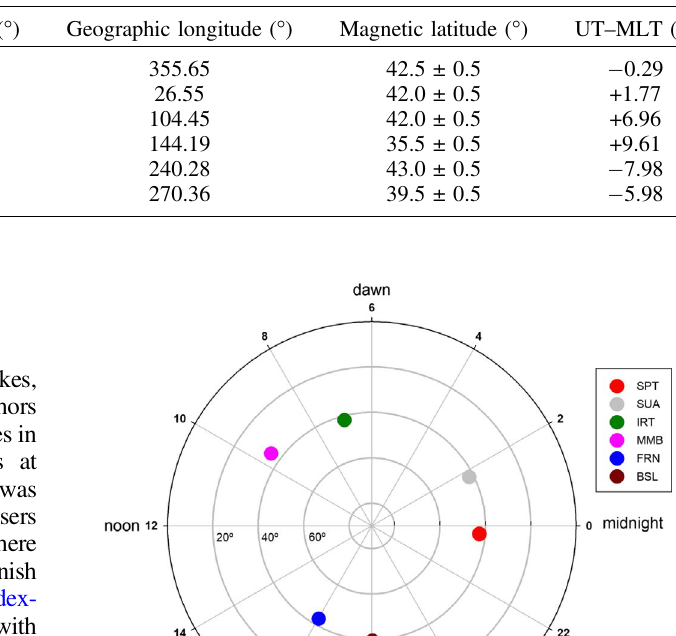
Table 2. Magnetic observatories used in the study. The fi fth column refers to the interval in which the magnetic latitude is included according to 2000 – 2015 IGRF models during the period analysed.